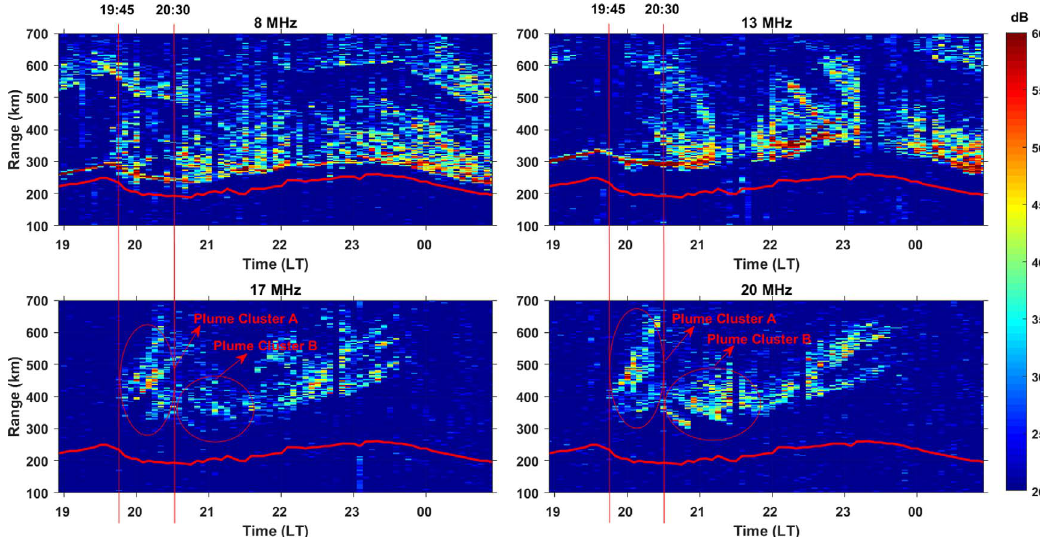
Fig. 7. Range – time – intensify from ionograms at PUR station at the frequency of 8, 13, 17, 20 MHz on 13 March 2015. The upwelling backscatter plumes marked by cluster A, and the descending backscatter plumes marked by cluster B. The red line indicates variations of h ’ F2.